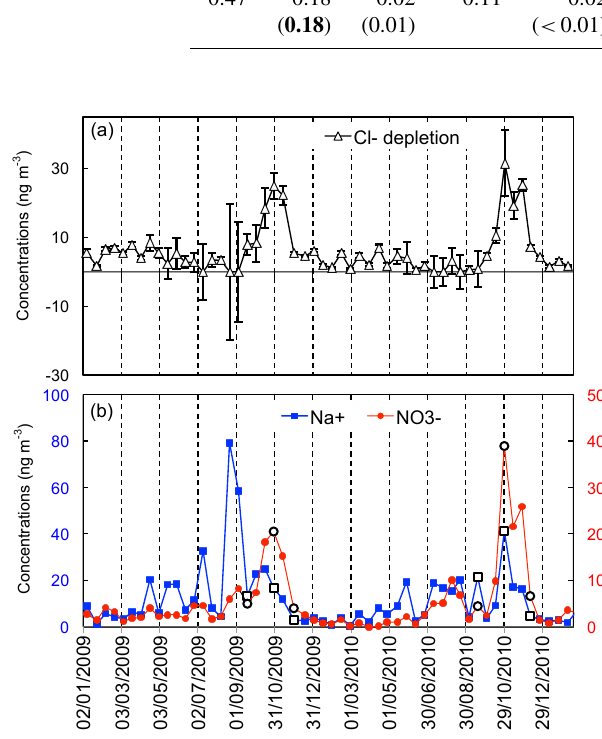
Figure 5. (a) Cl − depletion relative to Na + with respect to the com- position of freshly emitted sea-salt aerosol (Eq. 2) and (b) concen- trations of Na + and NO − in aerosol collected on the 12-stage im- 3 pactor in 2009 and 2010 (biweekly sampling). Vertical bars refer to uncertainty in calculating the chloride depletion (Eqs. 3 and